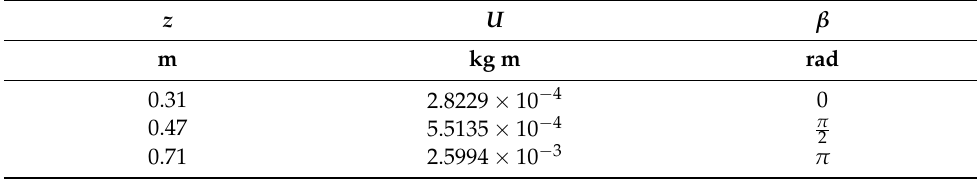
Table 3. Unbalance of case A.